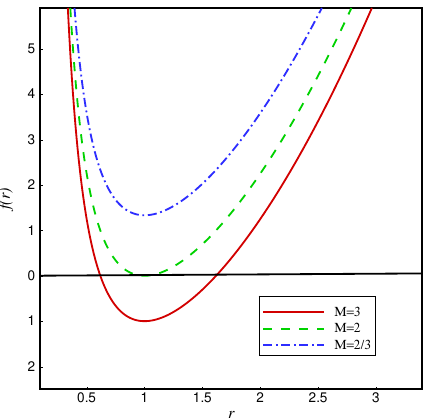
Figure 4 . The behavior of f ( r ) for rotating black hole in 3D with different M , where we have taken l = 1 and J = 2 .